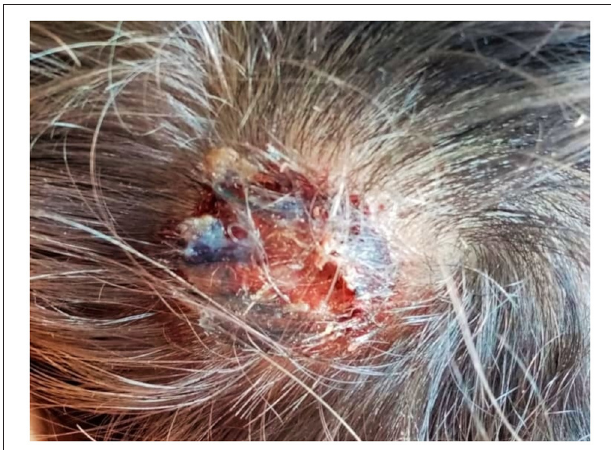
FIGURE 1 | Child’s scalp lesion, showing hair loss, pus discharge and